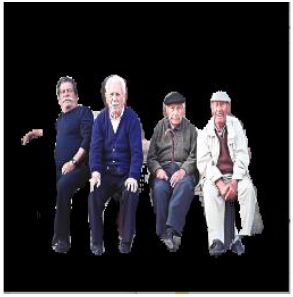
Figure 8. Results of ROI masked